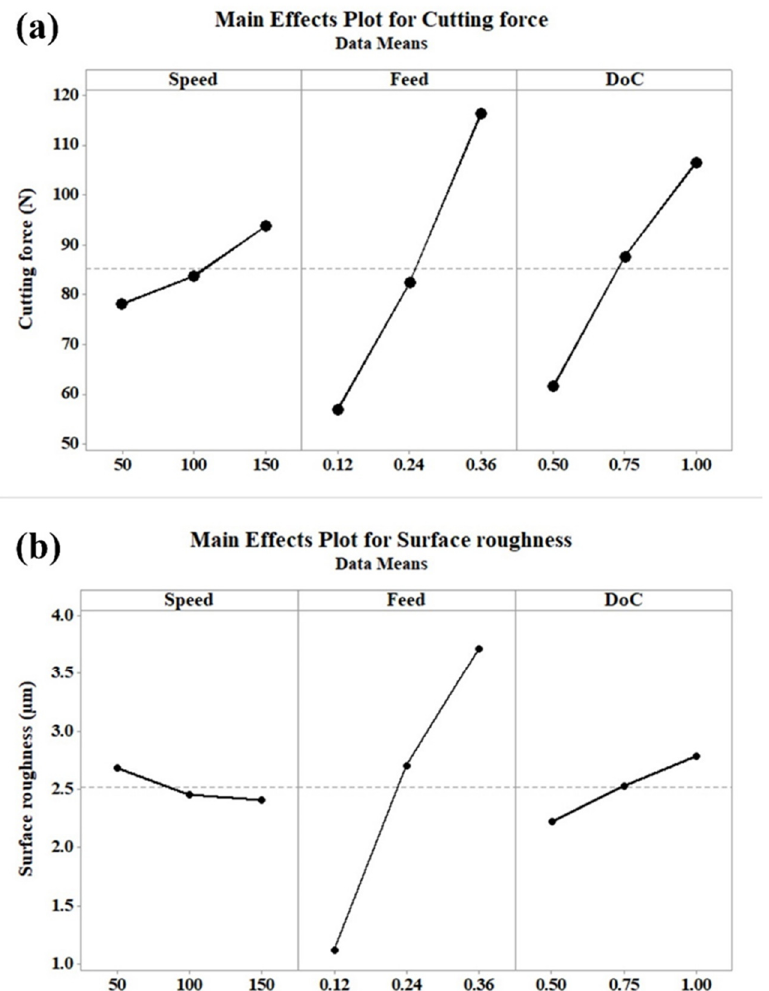
Figure 3. Main effects plots for ( a ) cutting force and ( b ) surface roughness of the RZ5/8 wt.% TiB 2 composite .